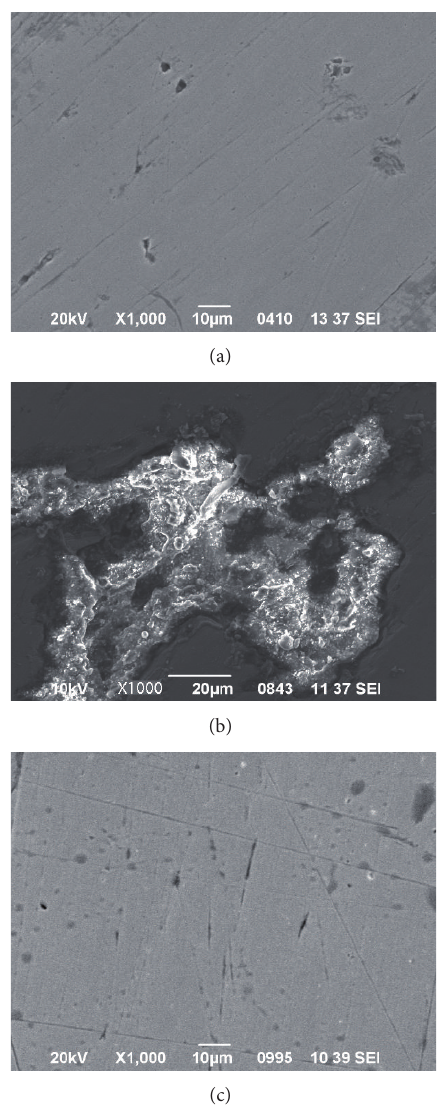
F 5: SEM analysis of carbon steel� magni�cation (control). (b) Carbon steel immersed in well water,